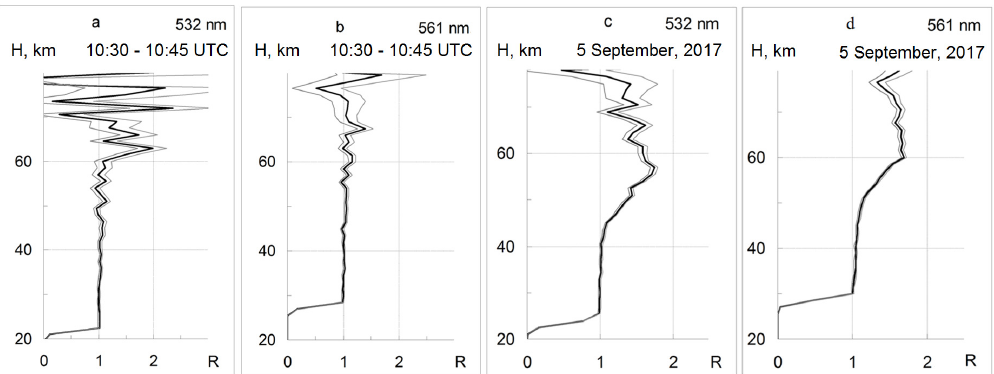
Figure 10. Vertical profiles of the scattering ratio of lidar signals recorded on 5 September 2017: ( a , b ) before the occurrence of a light-scattering layer in the thermosphere at 10:30–10:45 UTC; and ( c , d ) overnight accumulation of the scattering ratio on 5 September 2017. The thin curves indicate the standard deviations of the scattering ratio.